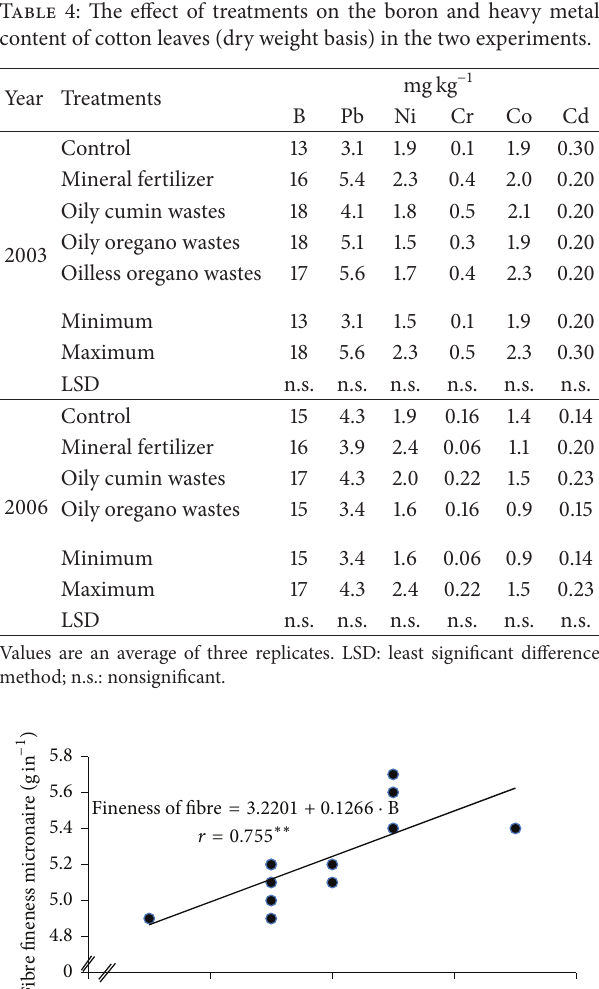
Table 4: The effect of treatments on the boron and heavy metal content of cotton leaves (dry weight basis) in the two experiments.